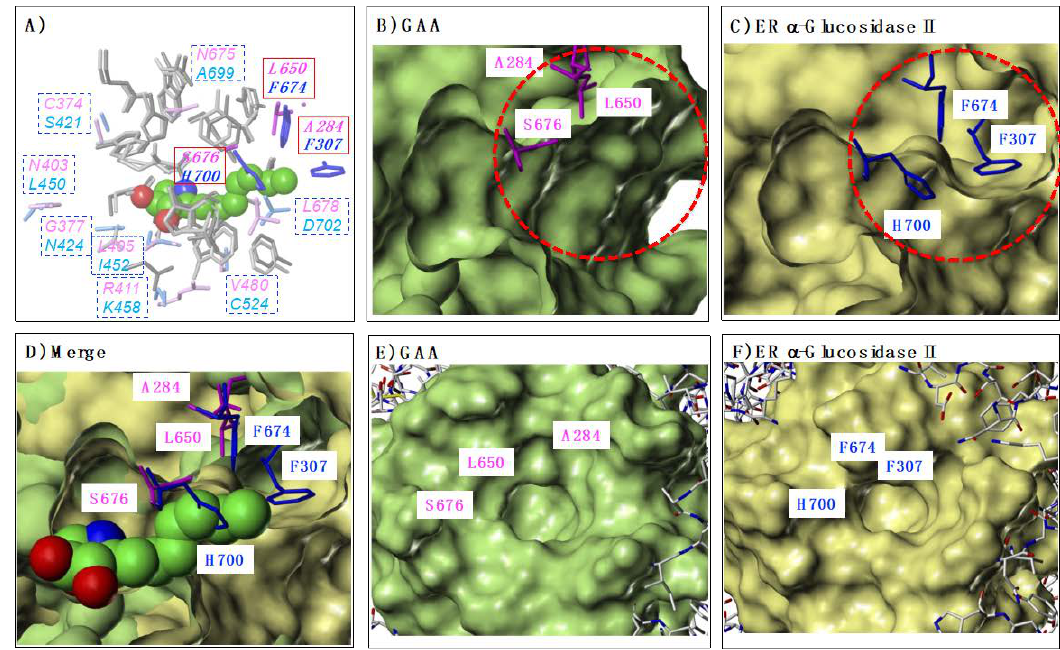
Figure 7. Di ff erence of LAB-alkyl chain storage pocket in GAA and ER α -glucosidase II. ( A ) The amino acids of GAA and ER α -glucosidase II within 5Å surrounding the α -1- C -hexyl-LAB. The amino acids that di ff er between GAA (magenta) and ER α -glucosidase II (blue) were displayed in the square box. ( B ) The protein surface of GAA and the characteristic three amino acids, which composed the opening part (red dotted circle) of the active site. ( C ) The protein surface of ER α -glucosidase II and the characteristic three amino acids which composed the opening part (red dotted circle) of the active site. ( D ) The superimposition of each protein surface of GAA and ER α -glucosidase II. Docking pose of α -1- C -hexyl-LAB against GAA was superimposed with them. ( E ) GAA protein surface from the view of the outside of the opening part of the active site. ( F ) ER α -glucosidase II protein surface from the view of the outside of the opening part of the active site.